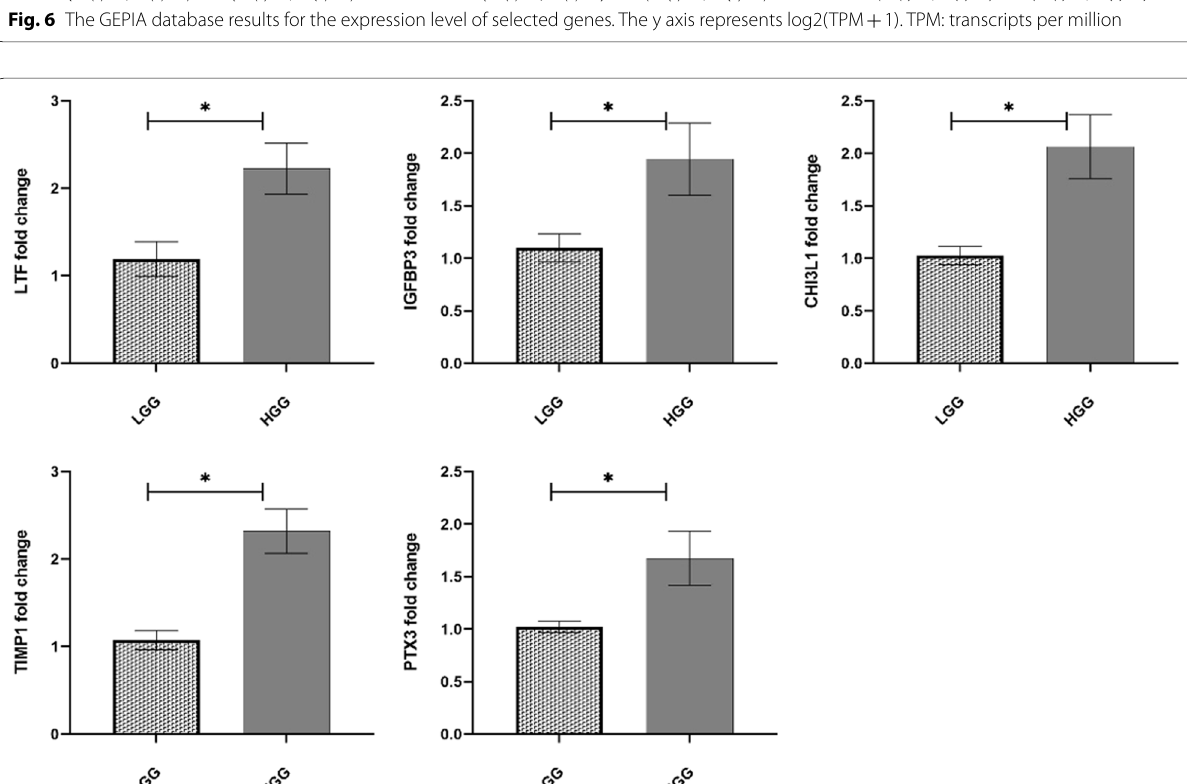
Fig. 7 Mean relative expression of LTF , IGFBP3 , CHI3L1 , TIMP1 and PTX3 in HGG compared to LGG in patient